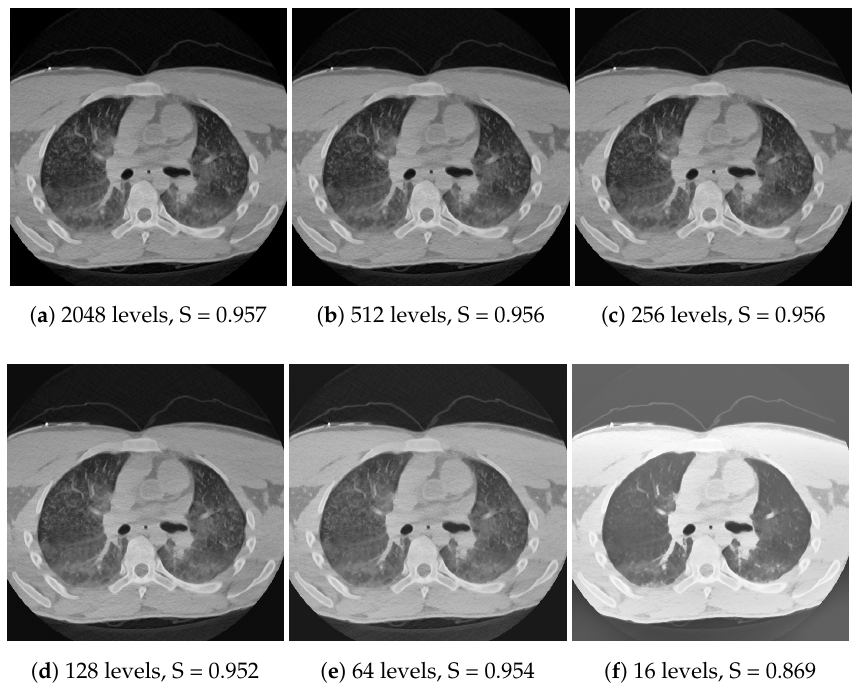
Figure 11. Calculating the histograms using a decreasing number of discretization levels. While quality slightly degrades after a while, the linear interpolation and dithering make the algorithm robust. TMQI structural similarity slowly decreases as the approximation becomes coarser.